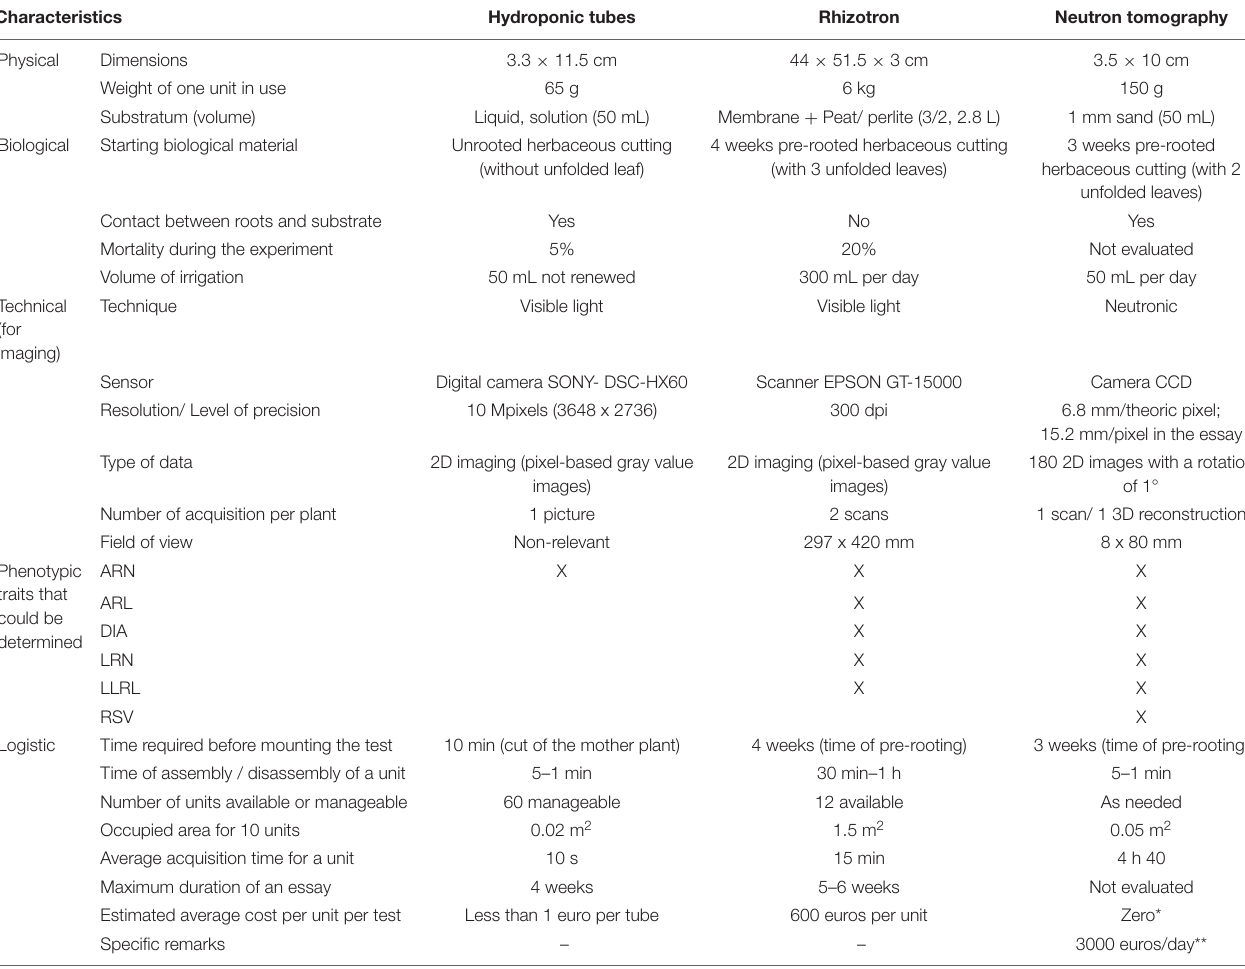
TABLE 2 | Comparison of the three devices assessed: hydroponic tubes, 2D-rhizotron, and neutron tomography.